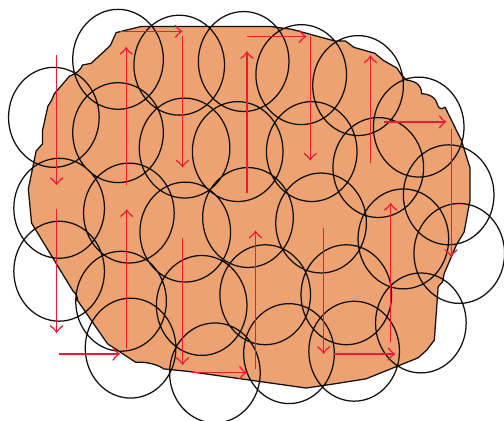
Figure2:“Stepladder”patternisfollowedduringcapturingprocess. Each circle represents one eyepiece view. Multiple overlapping circles covering the entire tissue section are